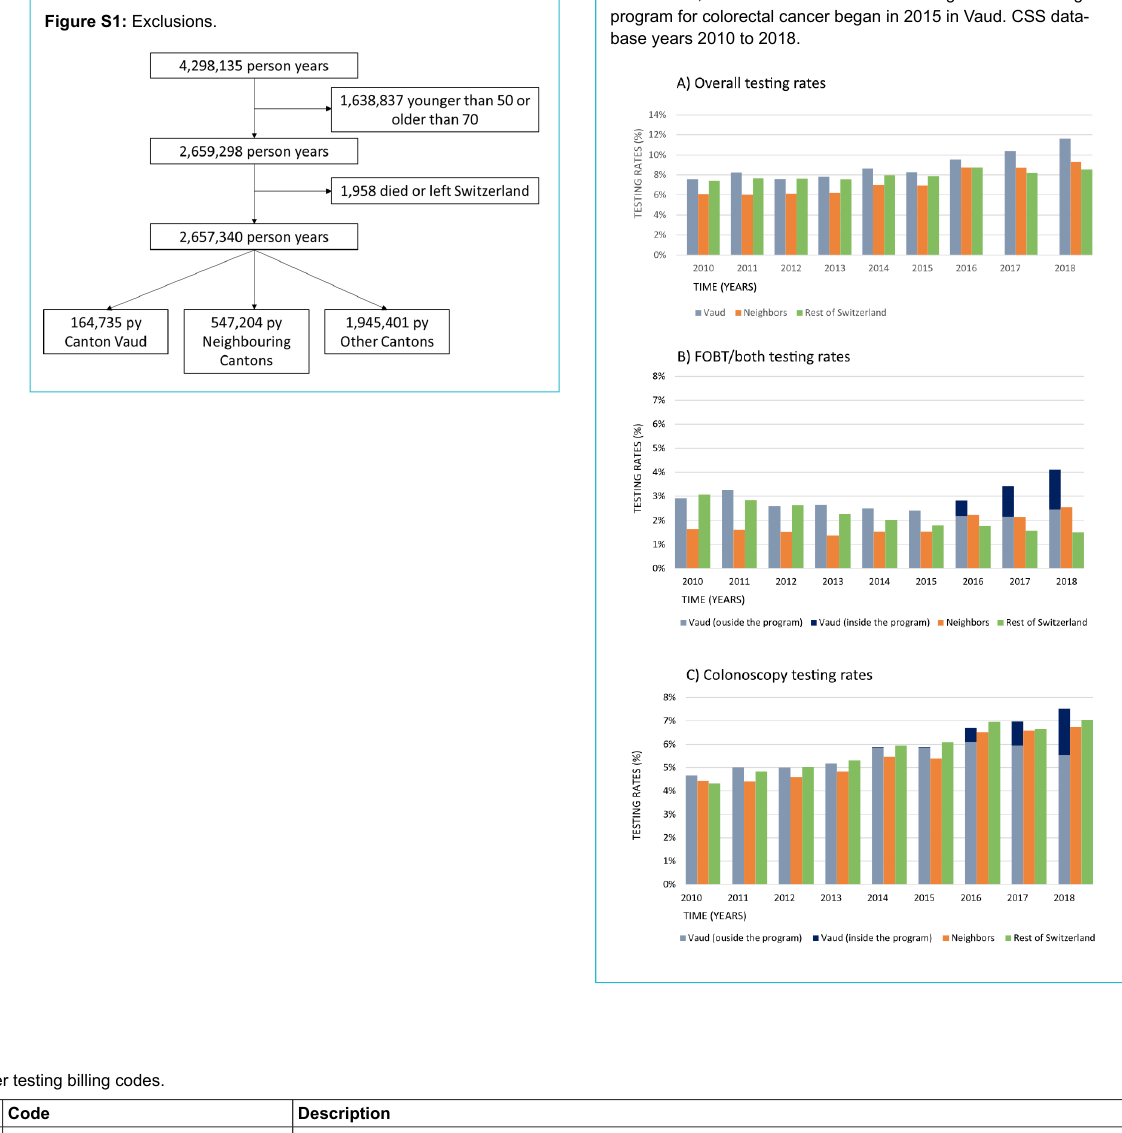
Figure S1: Exclusions.